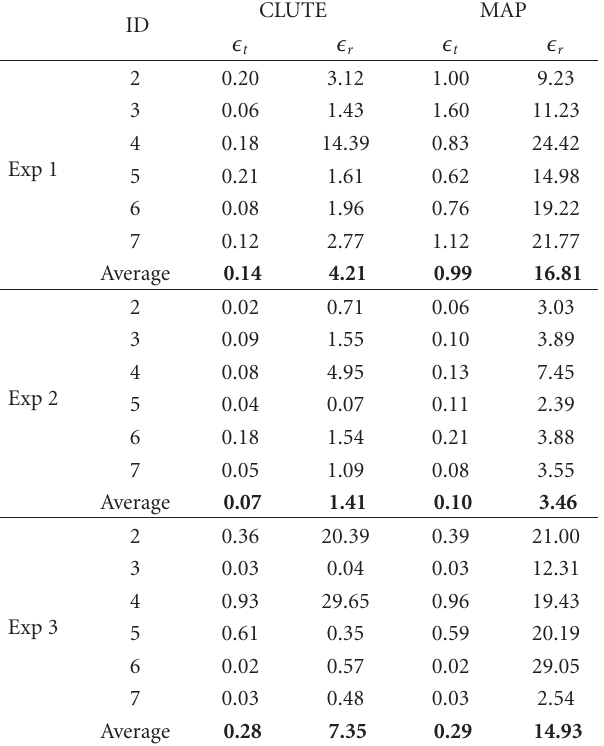
Table 8: 8-camera network: comparison between CLUTE and MAP in case of the failure of 1 camera.